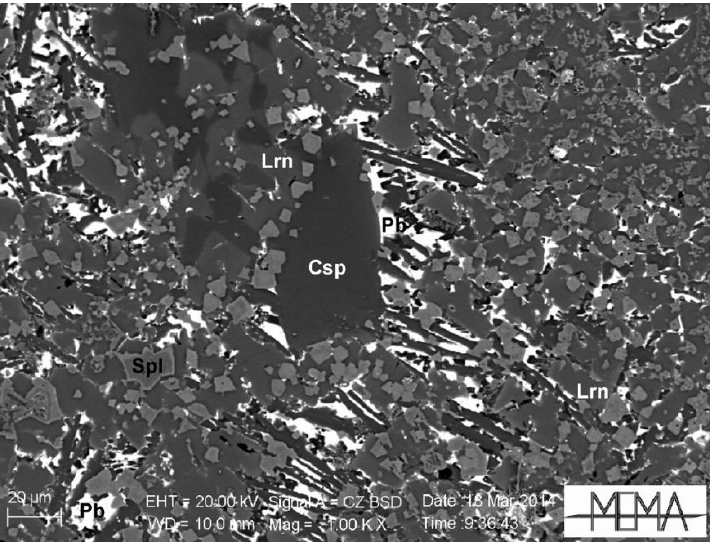
Figure 7. BSE image of a matte poor slag (II) sample from Montieri with cuspinine, larnite, zoned spinels and metallic lead. Abbreviation: Lrn—larnite; Spl—zoned spinels; Csp—cuspidine.